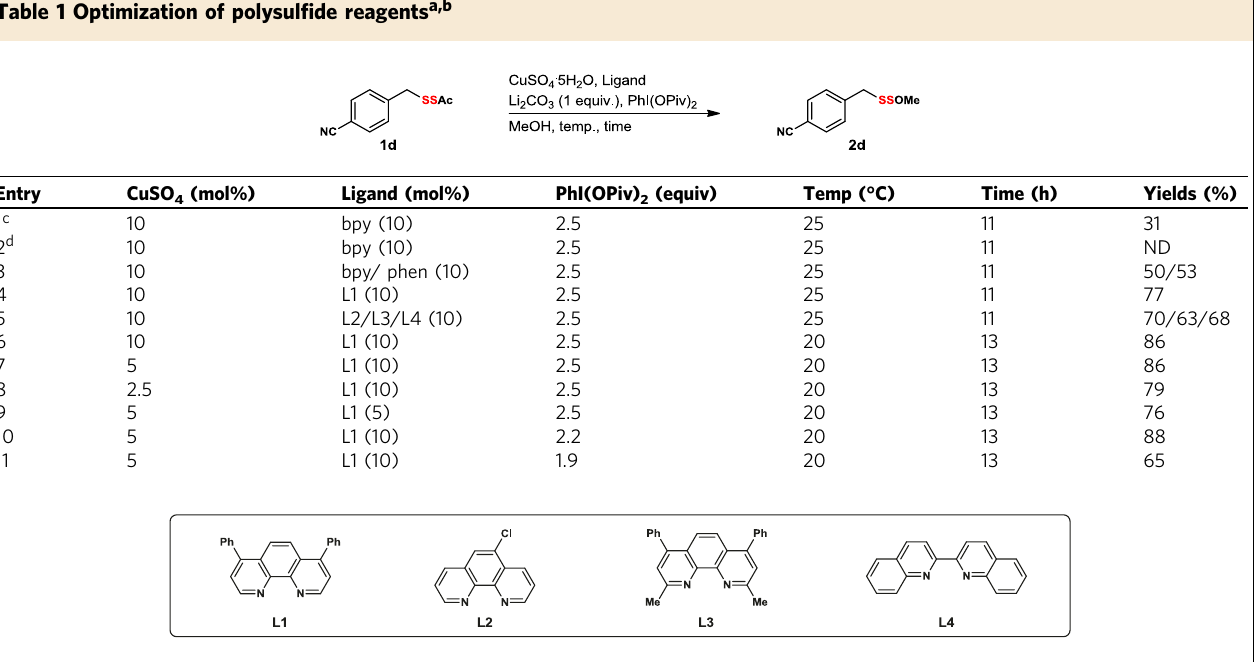
Table 1 Optimization of polysul fi de reagents a,b